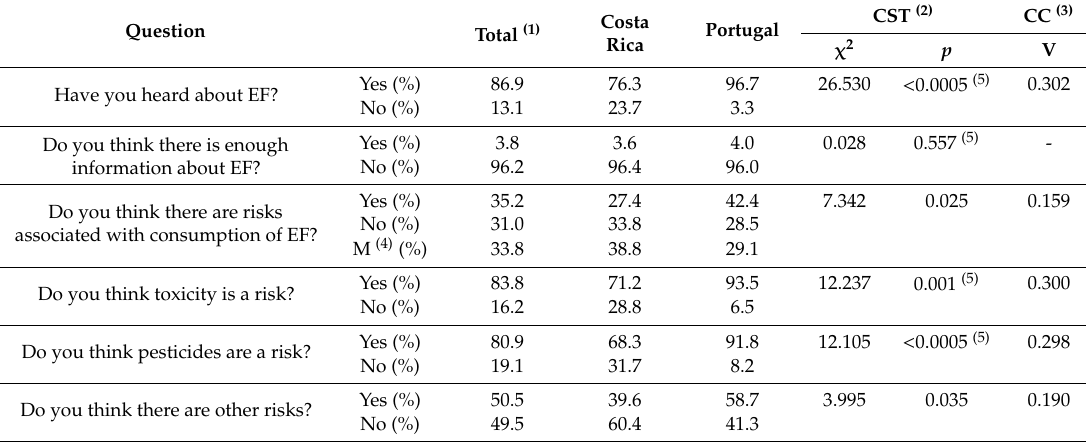
Table 3. Information about edible flowers (EF), according to